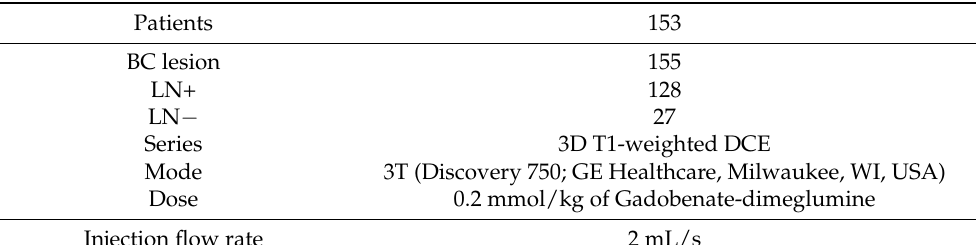
Table 1. Details about the involved